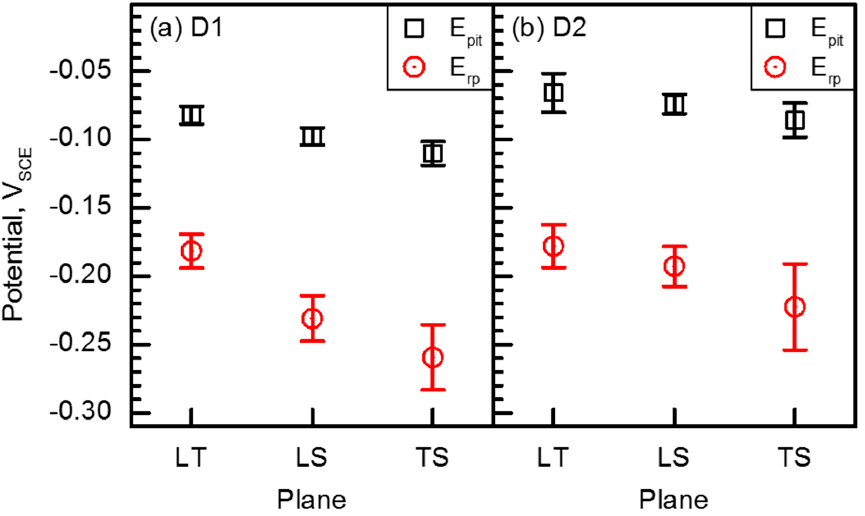
Figure 5. E pit and E rp values of ( a ) D1 and ( b ) D2 specimens measured on the LT, LS, and TS planes in 2 M NaCl solution at 50 °C at a potential sweep rate of 1 mV·s − 1 .